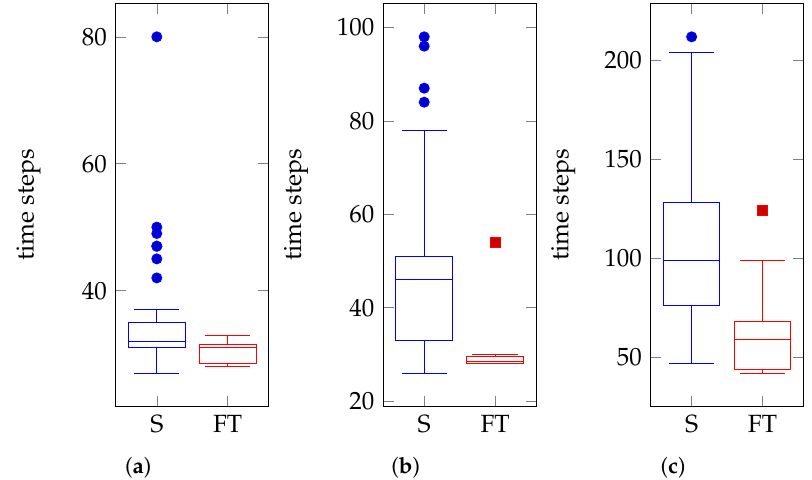
Figure 15. Data distribution of executed time steps by the POMDP solver until the victim was detected with a confidence ζ ≥ 0.7 and position coordinate p v = ( 1.5, − 1.4,0.0 ) . HIL simulations (S) are indicated in blue and real flight tests (FT) in red. ( a ) Results under a single victim belief cluster. ( b ) Results under two victim belief clusters. ( c ) Results under a uniform belief cluster.